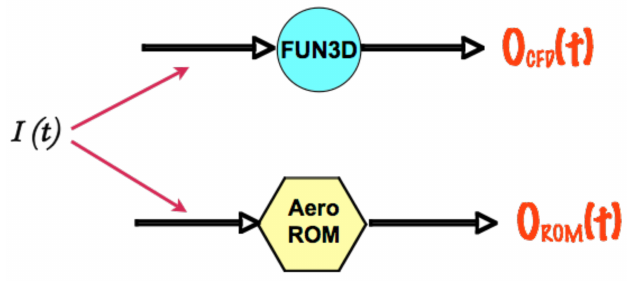
Figure 5. Error defined as difference between the FUN3D solution and the unsteady aerodynamic ROM solution due to input of orthogonal functions.